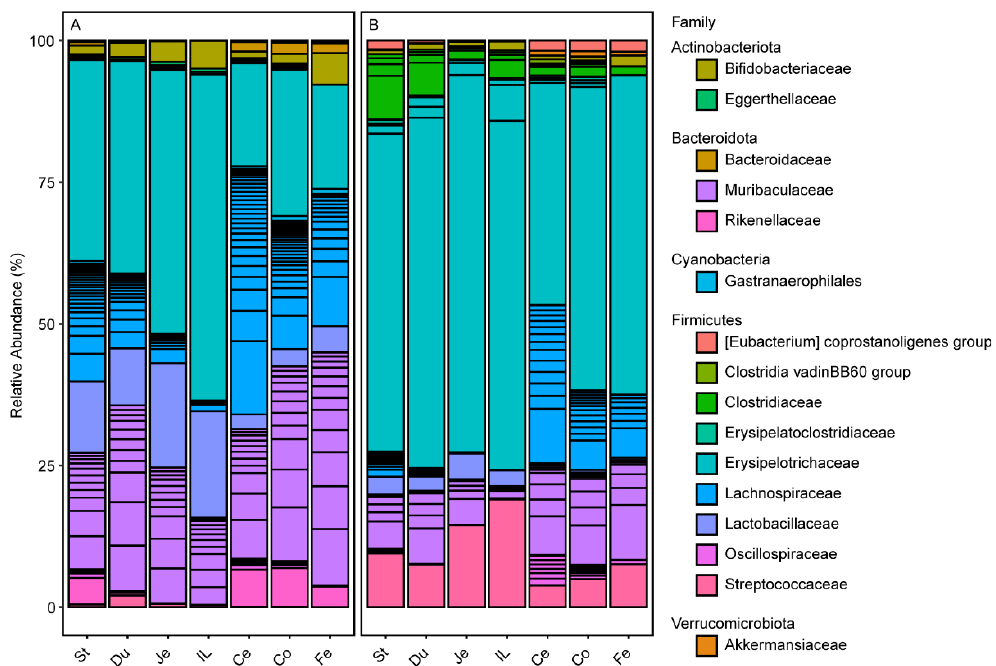
Figure 4. Gut microbiota classified at the family level. ( A ) Standard diet fed mice. ( B ) Western diet fed mice. Black horizontal lines on the bar-plots demarcate the different ASVs. Taxa are arranged alphabetically by phylum as indicated in legend headings. St: stomach; Du: duodenum; Je: jejunum; Il: ileum; Ce: cecum; Co: colon; Fe: fecal.